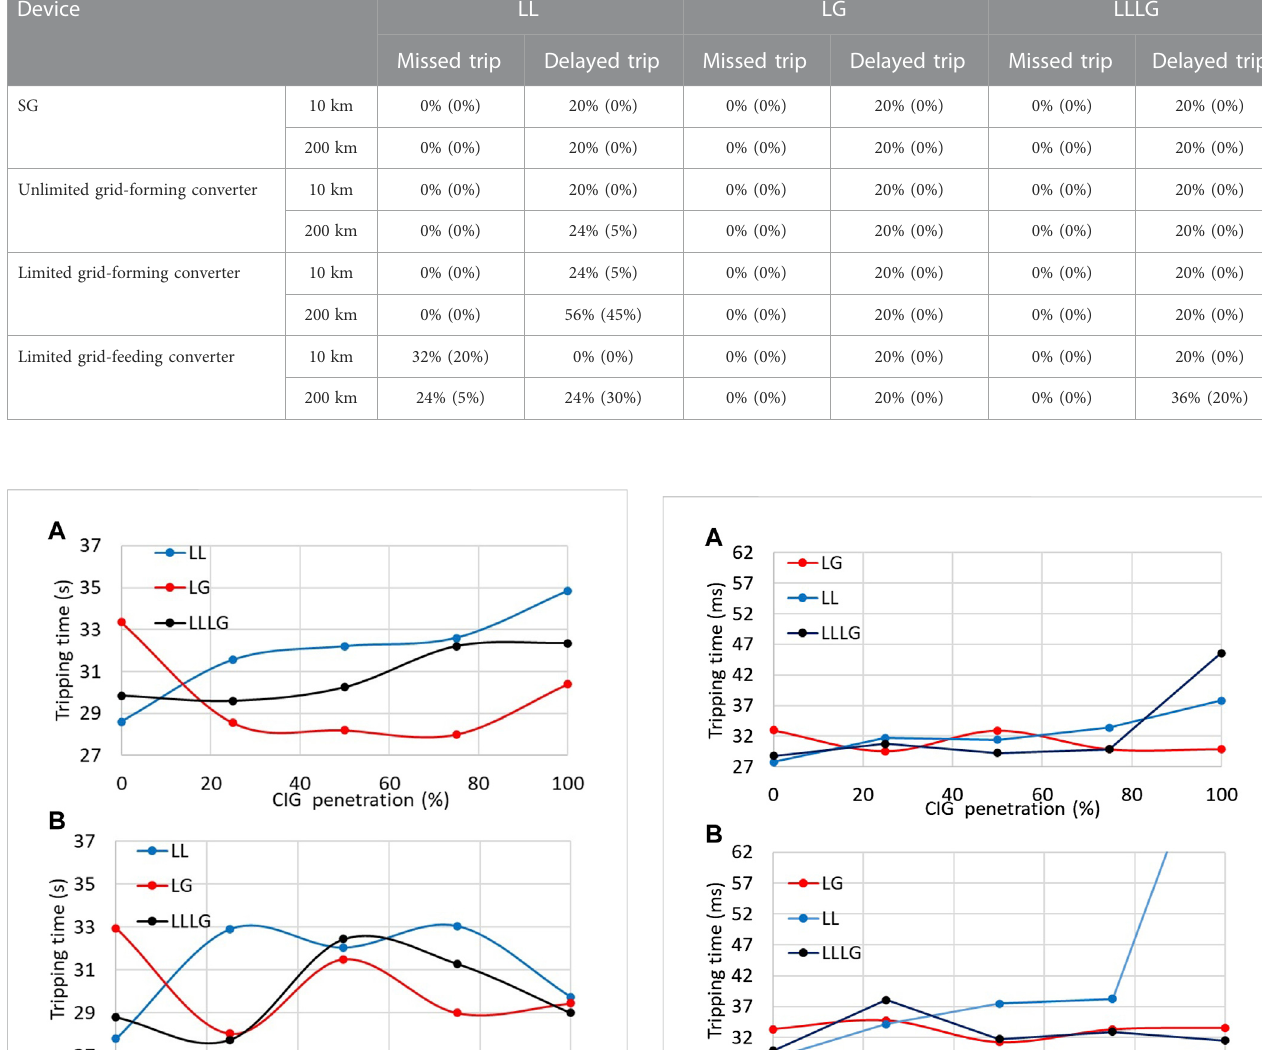
TABLE 3 Percentage of missed and delayed trips per type of fault per device, zone 1 result in brackets, zone1+zone2 result besides. Device